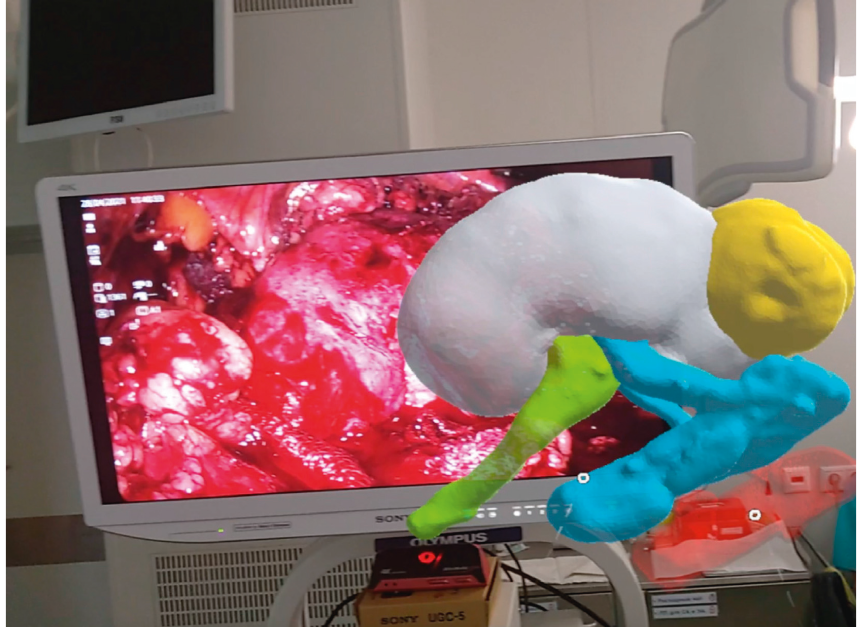
Figure 3: Transparent 3D mixed reality model anchored in front of the surgeon and matched to the real-time videoendoscopic picture during